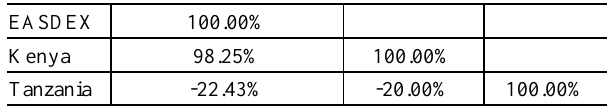
Table 7: Correlation analysis: EASDEX and the East African indices